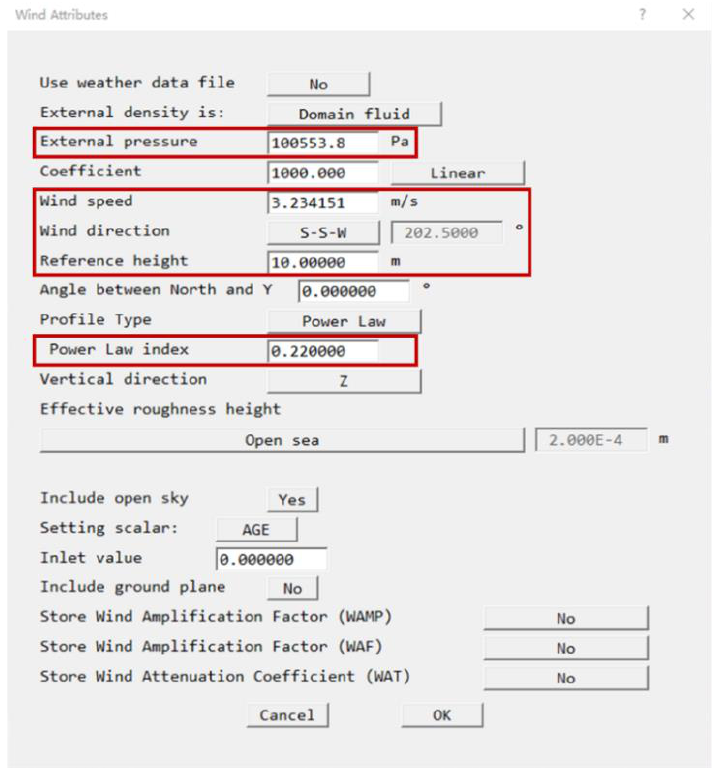
Figure A1. Phoenics wind environment attribute interface.